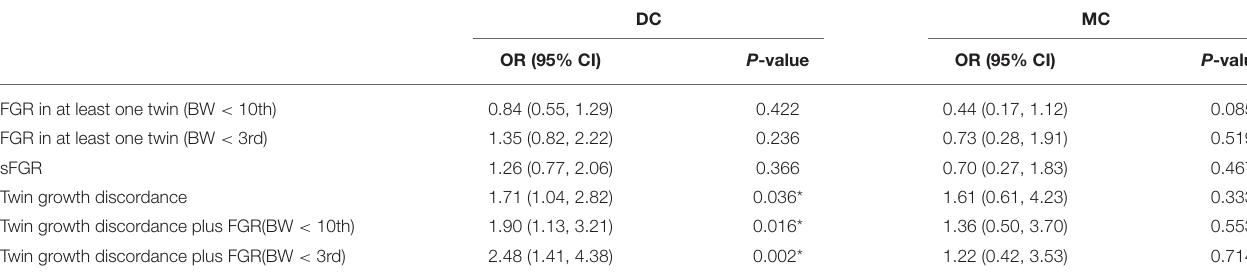
TABLE 5 | The Association between intertwin growth discordance, fetal growth restriction, and PPH stratified by chorionicity.